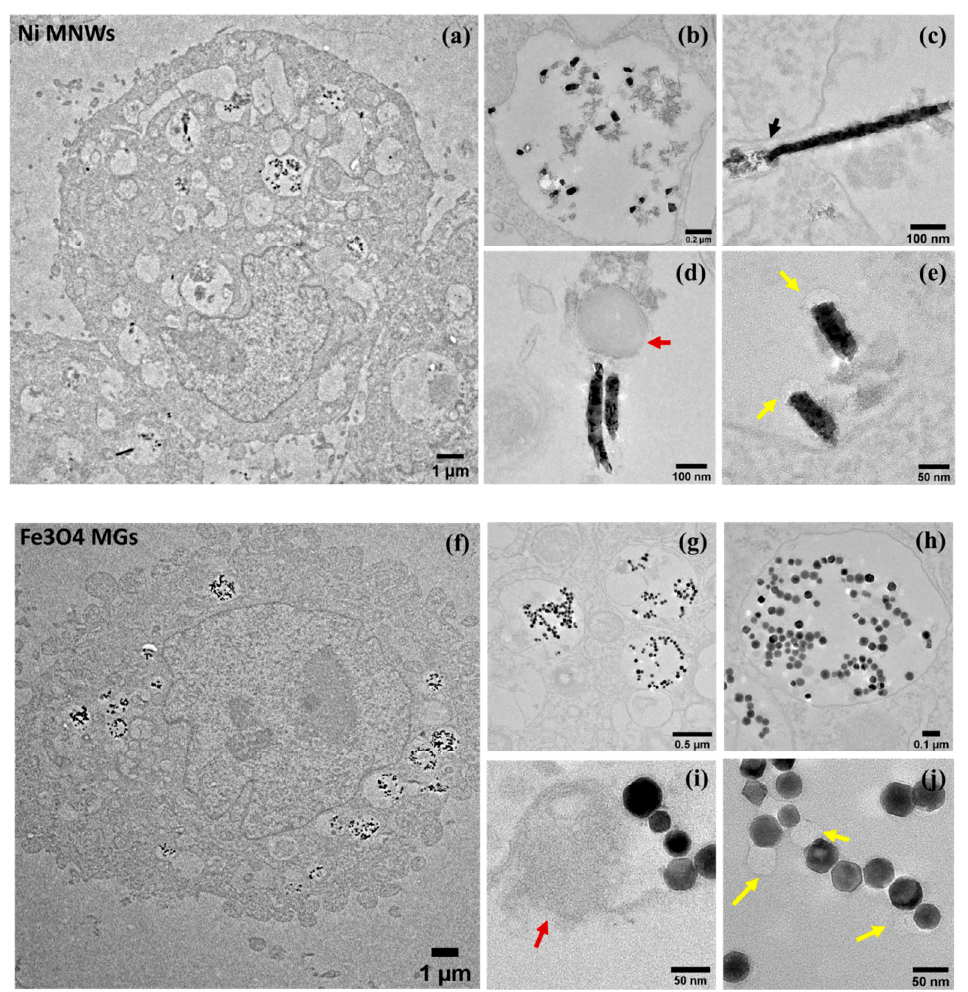
Figure 4. TEM images of Ni MNWs ( a – e ) and Fe 3 O 4 MGs ( f – j ) inside OSCA-8 cells. 30 μ g per 3 × 10 5 cells were employed for these studies. Red and yellow arrows have been employed to indicate the presence of different types of intra-endosomal vesicles, as explained in the main text.